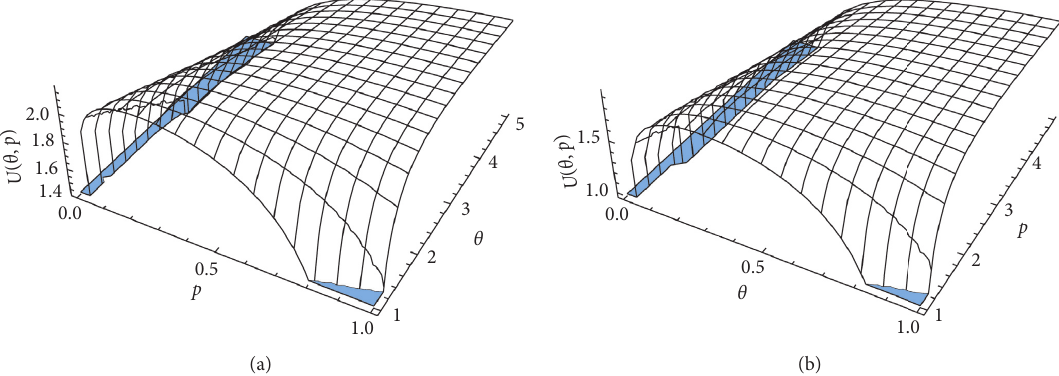
Figure 4: The relationship among U 0 . 5 , and δ � 0 . 8. (a) The basic social welfare model. (b) The extended social welfare model.